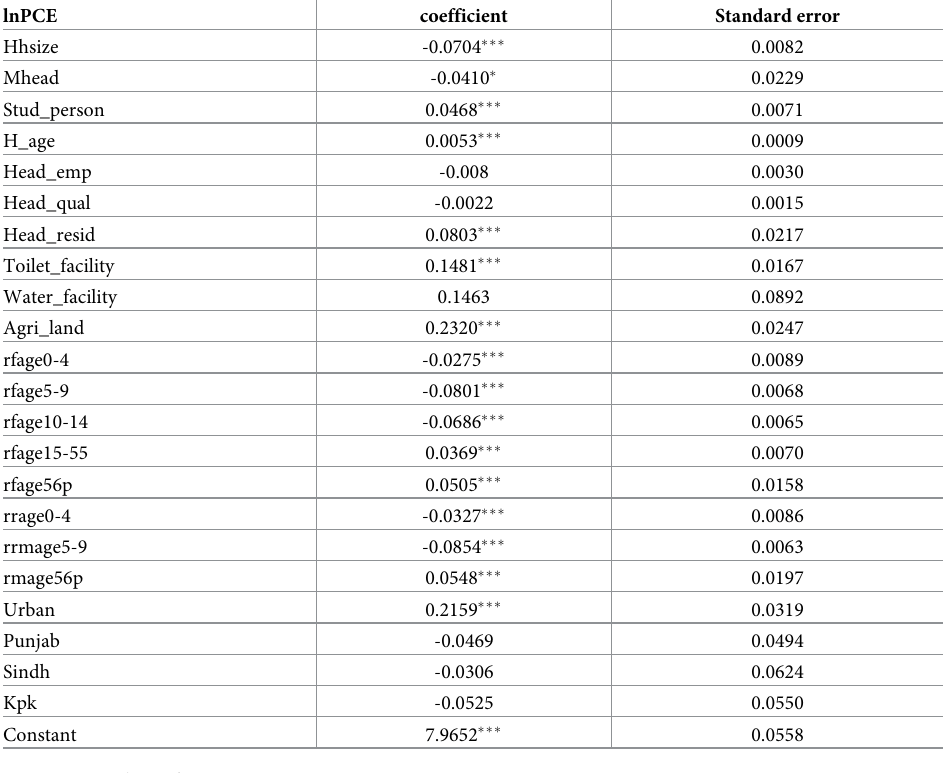
Table 5. OLS Regression estimates with simulated error